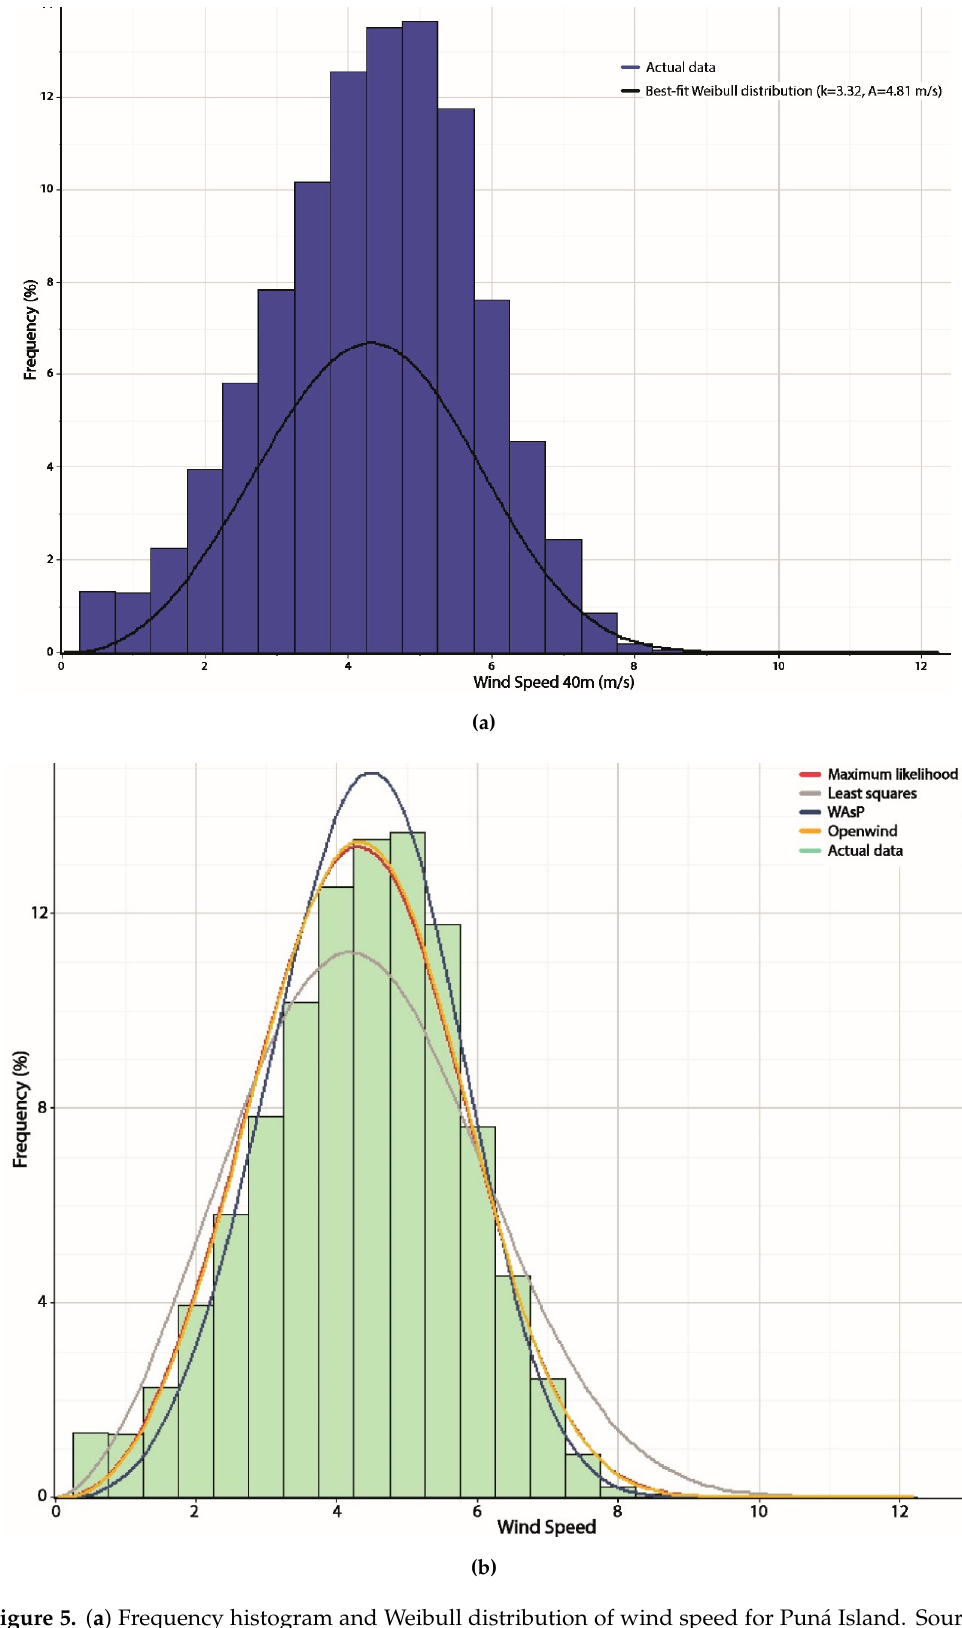
Figure 5. ( a ) Frequency histogram and Weibull distribution of wind speed for Pun á Island. Source: generated by the software. ( b ). Frequency histogram and several frequency distributions of wind speed for Pun á Island. Source: generated by the